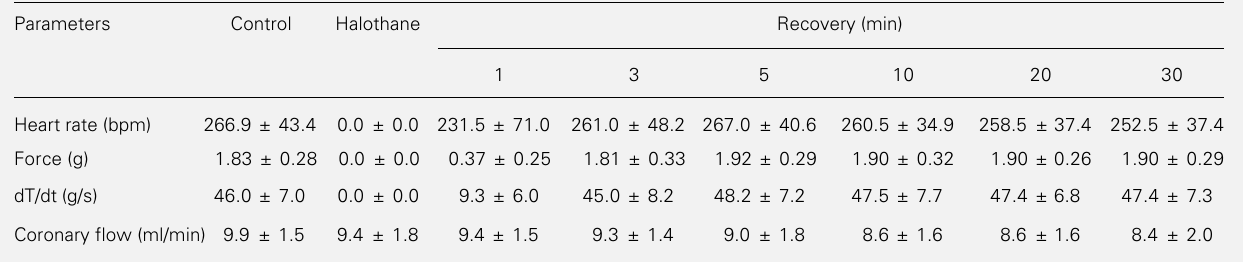
Figure 2 - Halothane-induced ar- rest and recovery in the isolated rat heart. A , Heart rate; B , dT/dt; C , coronary flow. Data are re- ported as means ± SEM for 10 rats. Abscissa: C = control; H = halothane; 1-30 min recovery period. *P<0.05 compared to control (Wilcoxon rank sum